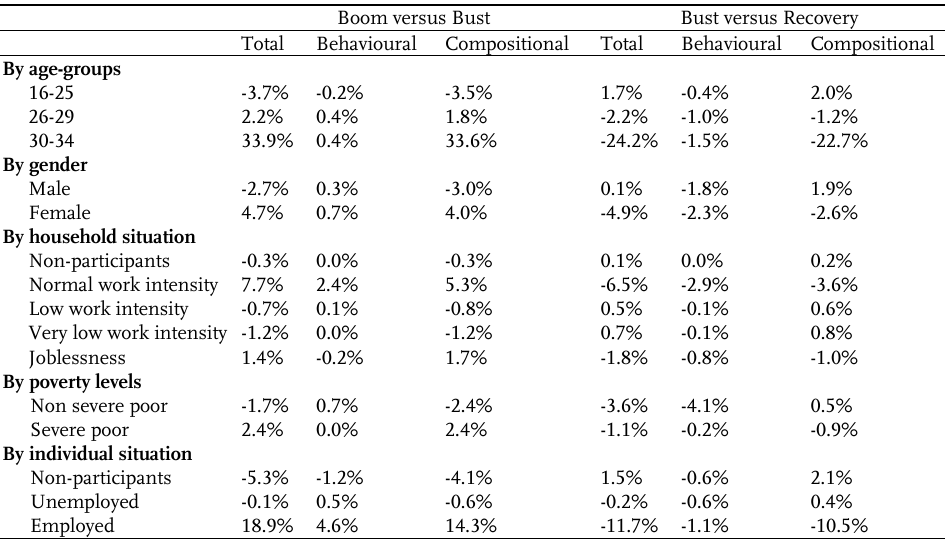
Table 2: Decomposition of the variation in youth living arrangements between business cycle periods (16-34): behavioural versus compositional Boom versus Bust Bust versus Recovery Total Behavioural Compositional Total Behavioural Compositional By age-groups